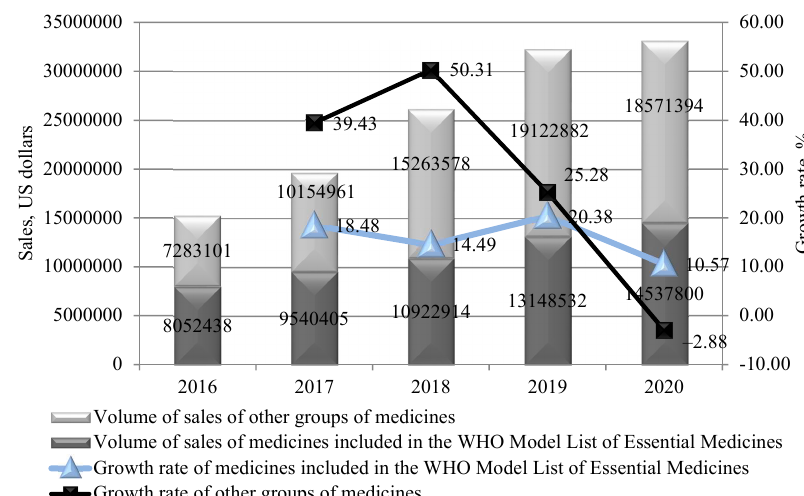
Fig. 8. Dynamics of indicators of sales volumes in cash of drugs included in the WHO Model List of Essential Medicines and other medicines for the pharmaceutical market of Ukraine